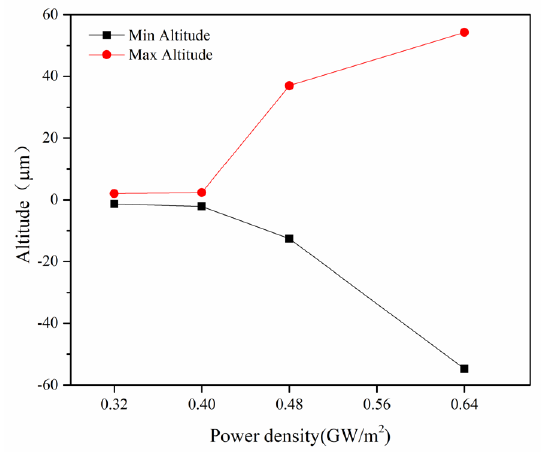
Figure 7. The 3D height color maps of the fully recrystallized samples under laser thermal shock with different power densities:( a ) 0.32 GW/m 2 ; ( b ) 0.40 GW/m 2 ; ( c ) 0.48 GW/m 2 ; ( d ) 0.64 GW/m 2 ; ( e ) the sectional image of ( c ) along the red dotted line; ( f ) the sectional image of ( d ) along the red dotted line.